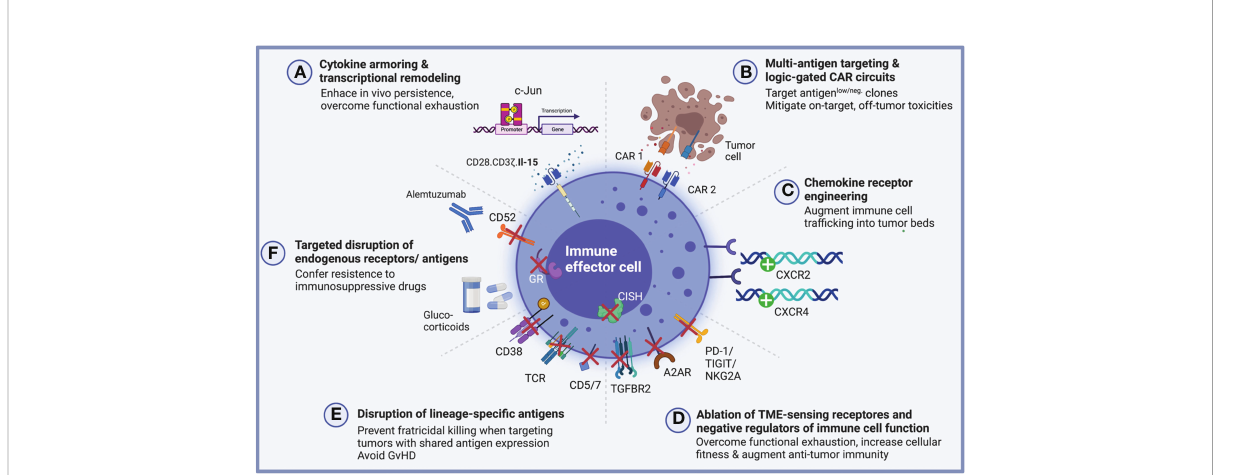
FIGURE 1 Multiplexed engineering and gene editing strategies to augment anti-tumor potency and cellular fi tness. A growing number of multiplexed engineering approaches have been pursued to enhance the cellular fi tness and augment anti-tumor potency of genetically engineered antigen- speci fi c immune effector cells. (A) Cytokine-armored immune effector cells are reprogrammed using a multi-cistronic vector system which endows them with antigen speci fi city and furthermore encodes for a speci fi c cytokine to provide autocrine growth support for